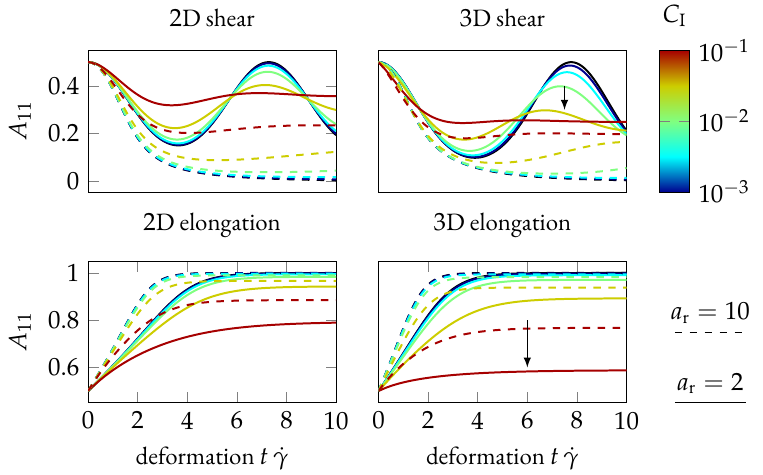
Figure 6. Influence of the dimensionality of the FT formulation for the case of shear and elongation for various FT parameters and two aspect ratios. The black line denotes the solution according to the Jeffery